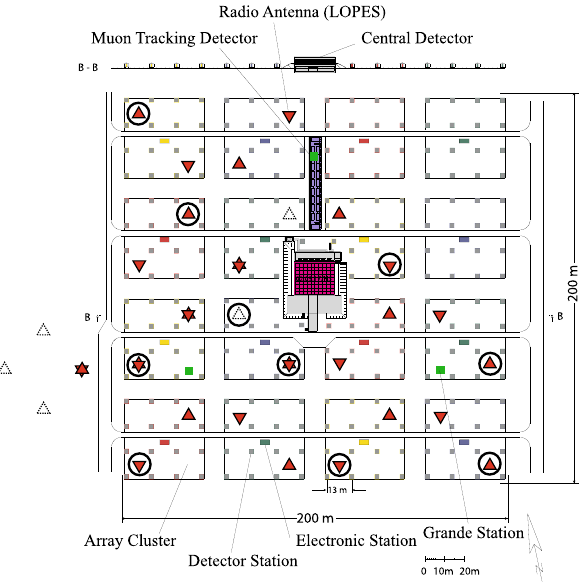
Fig. 3 Map of the LOPES and KASCADE arrays: east-west aligned antennas are marked with upward triangles, north-south aligned anten- nas with downward triangles (i.e., stars are antenna stations equipped with both polarizations), circles mark the positions of the tripole sta- tions deployed in 2009/2010, and dashed triangles mark those antennas dismantled in 2006 when deploying north-south aligned antennas